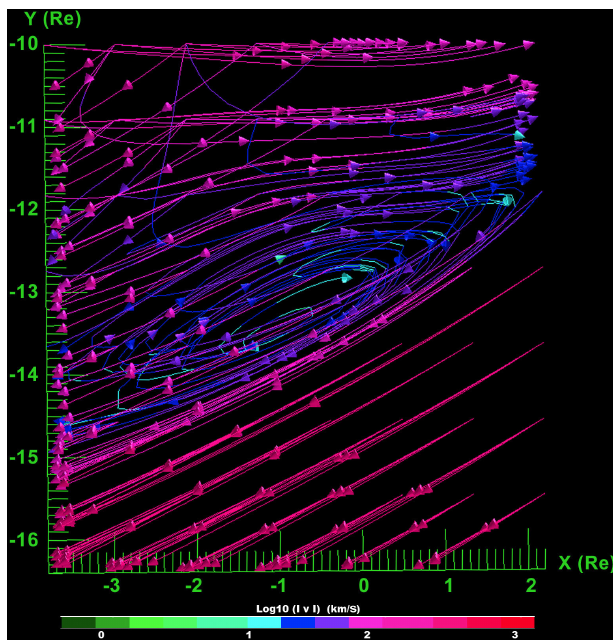
Fig. 3. Dawnside vortex rotating clockwise with its rotation axis aligned in the z direction (pattern 1) that developed during south- ward IMF within the first 15min of the simulation